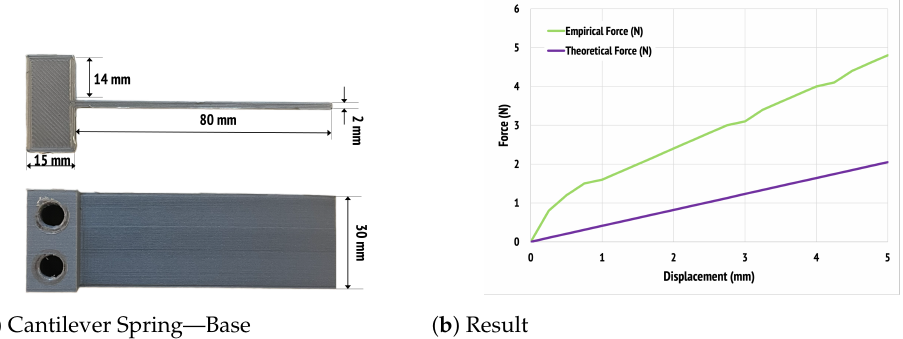
Figure 7. ( a ) 3D-printed base cantilever spring and its dimensions. ( b ) the results of force- displacement evaluation.